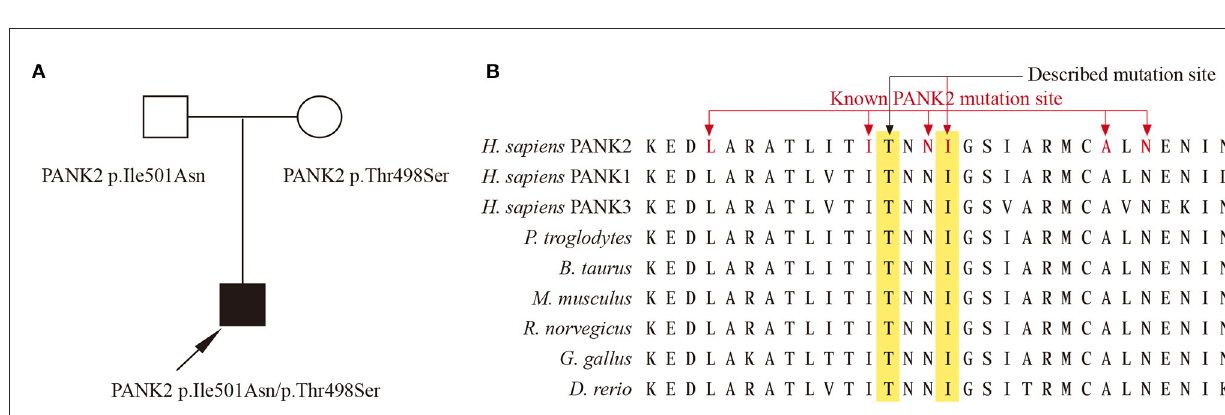
FIGURE1 T2-weighted brain MRI showing the “eye-of-the-tiger” sign.